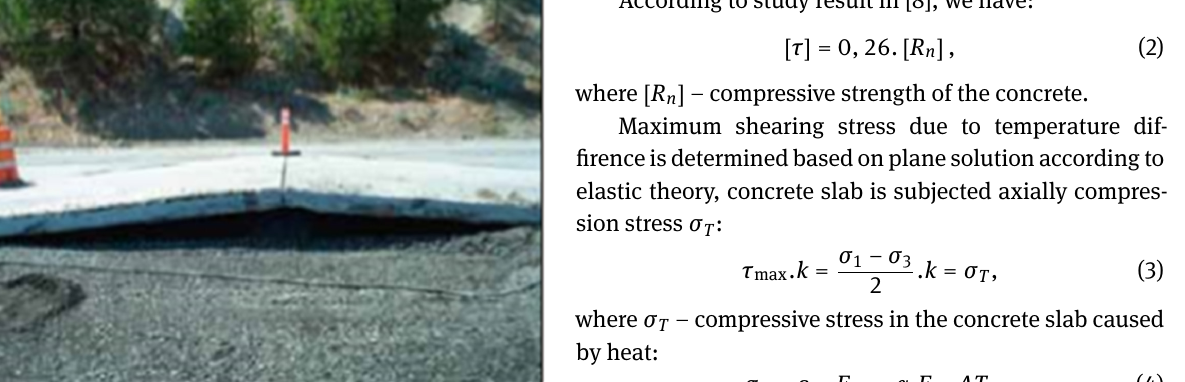
considering weather and climatic conditions of Vietnam based on the theoretical